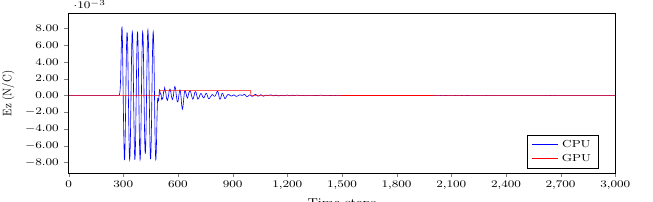
Figure 24. Comparison of the solution along the time obtained in the GPU vs. CPU in the control point 3. Very similar solutions were obtained for all other viewers. The solution can only be compared when the information is transferred to the